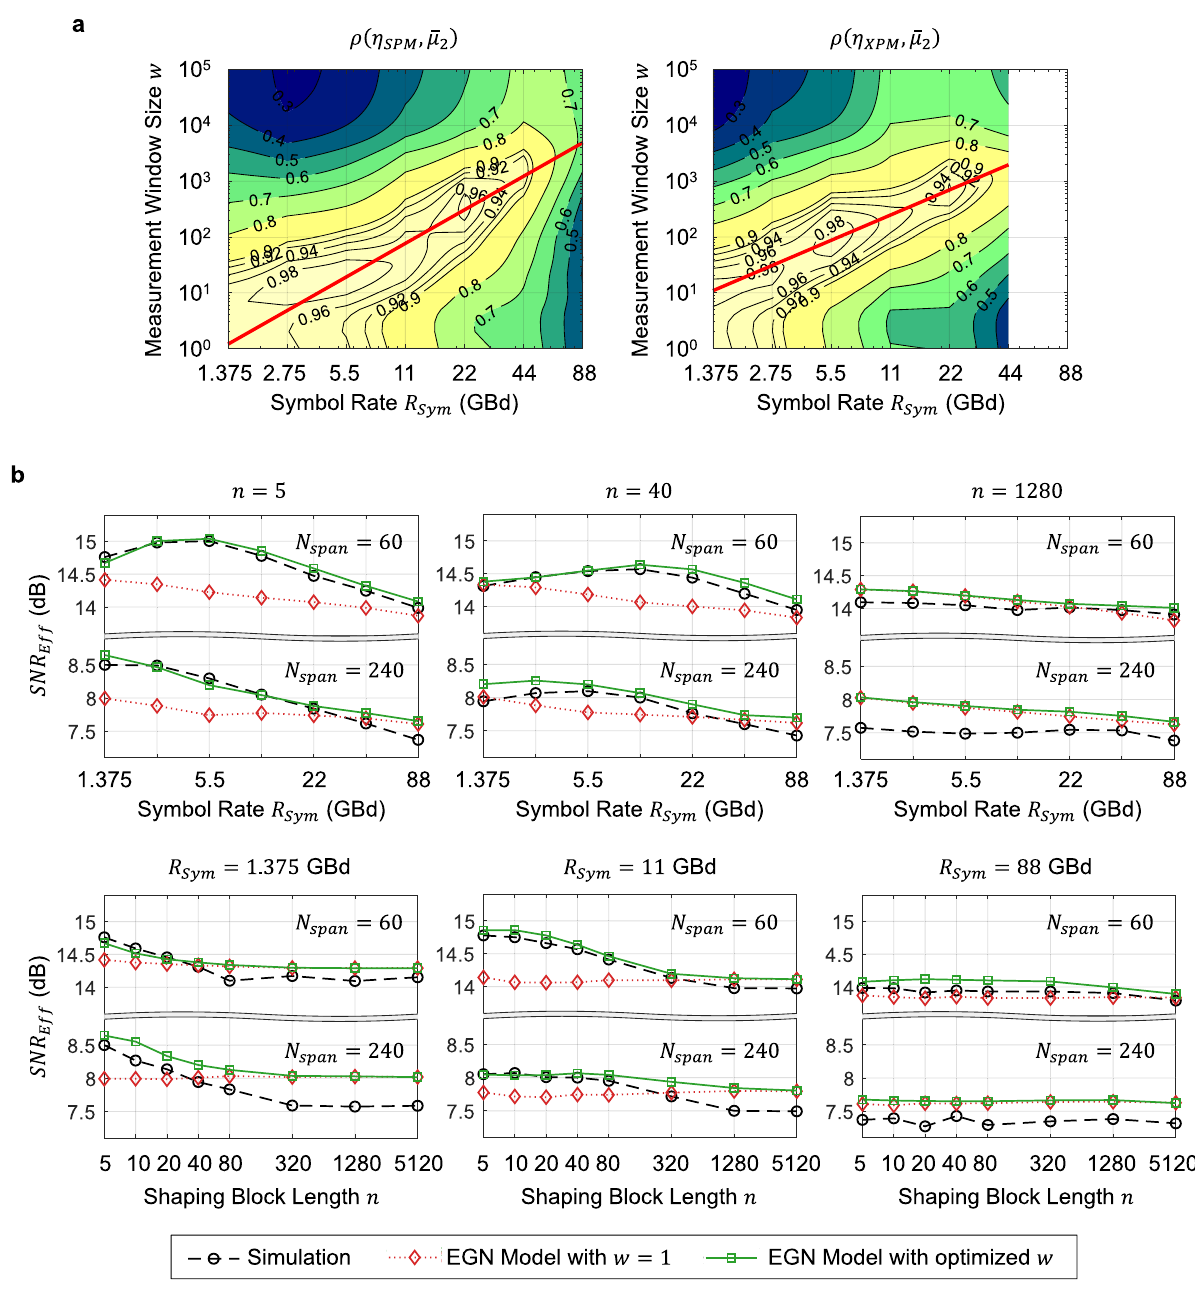
Fig. 3 The optimal window size for instantaneous power measurement and SNR Eff predicted by the EGN model using it. a Pearson correlation coef fi cients between η SPM and (cid:1) μ (left fi gure), and between η XPM and (cid:1) μ (right fi gure) with various window sizes w , obtained at 240 spans in Link D. The 2 2 red lines are obtained using Eqs. (7) and (8), estimated to produce the greatest correlation. There is no XPM at R Sym = 88 GBd, since only one channel is transmitted. b SNR Eff predicted by the EGN model, obtained with the optimal w (cid:5) SPM and w (cid:5) XPM (green solid lines) and traditional w ¼ 1 (red dotted lines), in comparison with the split-step simulation results (black dashed lines) at 60 and 240 spans in Link D. Source data for Fig. 3(a) are provided with this nm, and this trend of change also matches the simulation result in results in an increasing power excursion as the number of loops of Fig. 5(a, b), SNR of Fig. 2(a). Using the optimal n (cid:5) and R (cid:5) Eff Sym discrepancy in validation of theory. Typical recovered constella- Fig. 5(c) (orange circles) is obtained. Note that greater SNR Eff tions are shown in Fig. 4(a) next to the RX. Figure 5(a) and (b) than those in Fig. 5(c) are obtained with n smaller than n (cid:5) , but show, respectively, the optimal n (cid:5) and R (cid:5) that jointly maximize they provide smaller NDRs due to the reduced fundamental Sym j NDR in each channel. In general, n (cid:5) tends to increase as j D of the shaping ef fi ciency. Also shown in Fig. 5(c) is the SNR Total Eff (green solid line) increases, which is consistent with the shaping with the longest n ¼ 320 (blue triangles), chosen as a tends to decrease from 78.8 simulation result in Fig. 2(b). R (cid:5) (cid:12) benchmark for its best performance in linear channels, at a Sym (cid:12) ¼ 39 : 4 GBd that represents a widely used to 39.4 GBd when D increases from approximately 2 to 4 ns/ symbol rate of R Total Sym